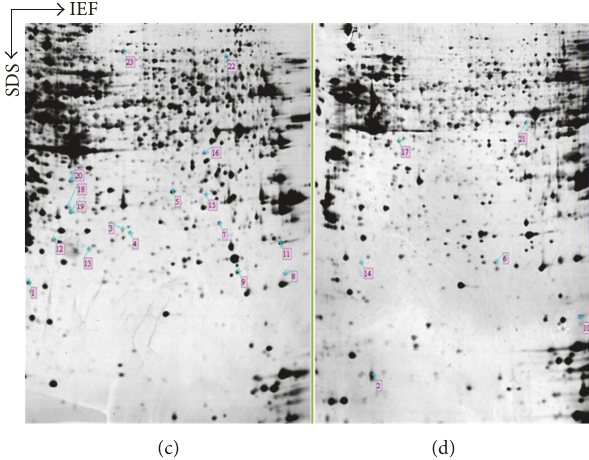
Figure 3: Two-dimensional electrophoresis (2DE) map of HUVEC. (c) Normal HUVEC; (d) HUVEC treated with 400 𝜇 mol/L elaidic acid.Firstdimension:IPG3–10,17 cm,NL;seconddimension:12.5% SDS- PAGE gels. Among the 23 different expression proteins, 22 spots were identified by peptide mass finger printing and MS/MS analysis. Corresponding identifications are reported in Table 2.